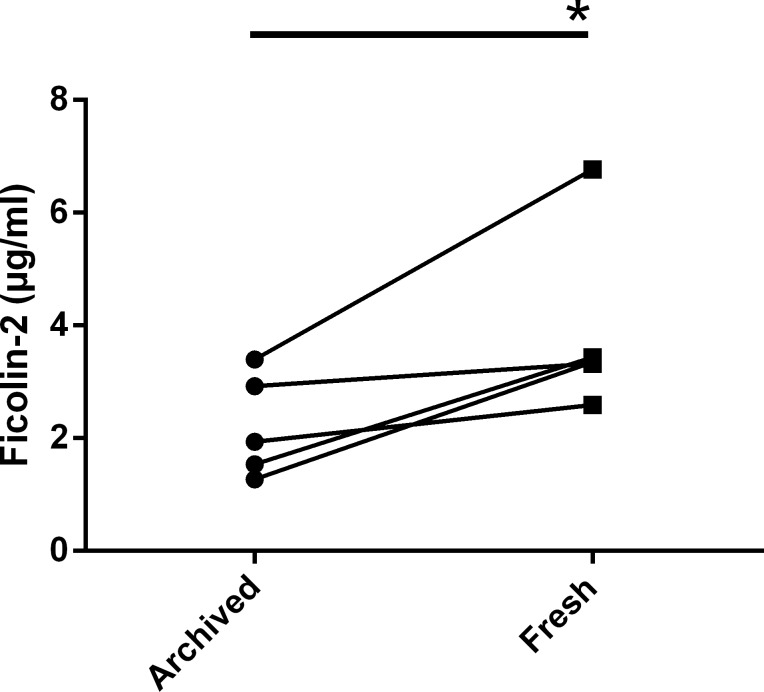
Freshly-collected sera from UAB Study of Aging participants whose archived samples inhibit ficolin-2 have significantly more ficolin-2 than their archived counterparts.Sera were assayed for ficolin-2 content by a commercial ELISA. *, P < 0.05 by paired t-test; connecting lines show matched samples. The mean ficolin-2 concentration (±SEM) was 2.21 ± 0.41 µg/ml for archived sera and 3.89 ± 0.73 µg/ml for matched freshly-collected sera.